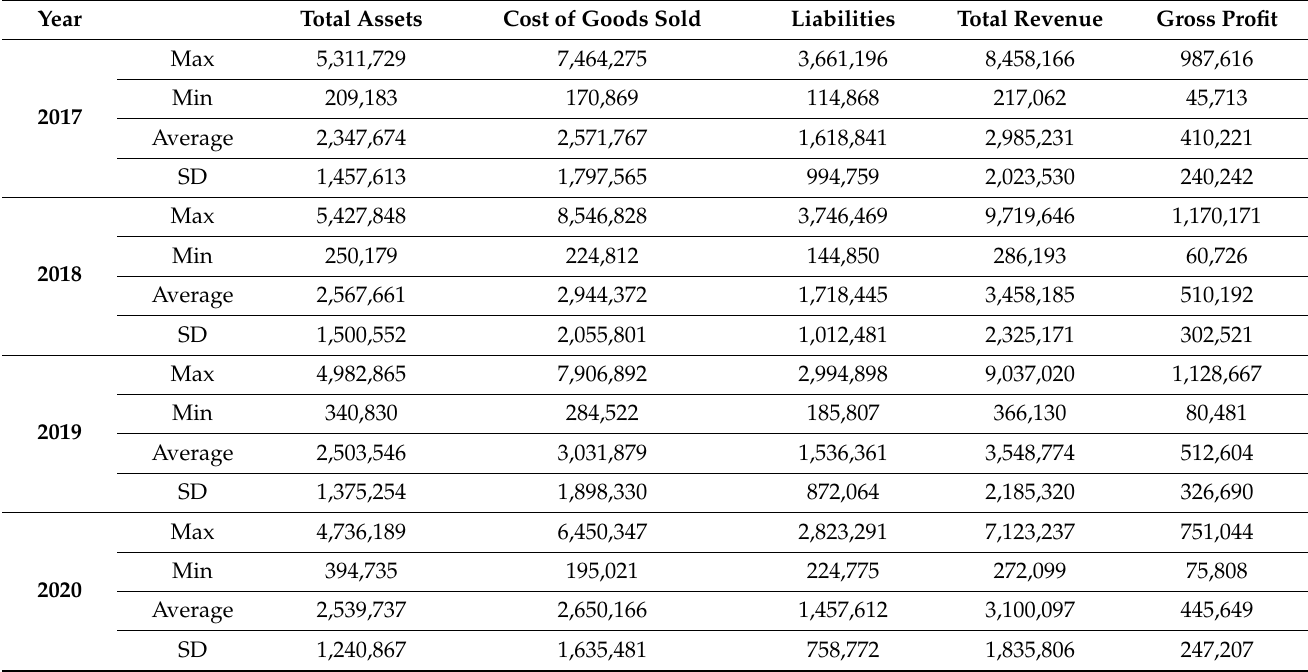
Table 10. Statistics of input/output